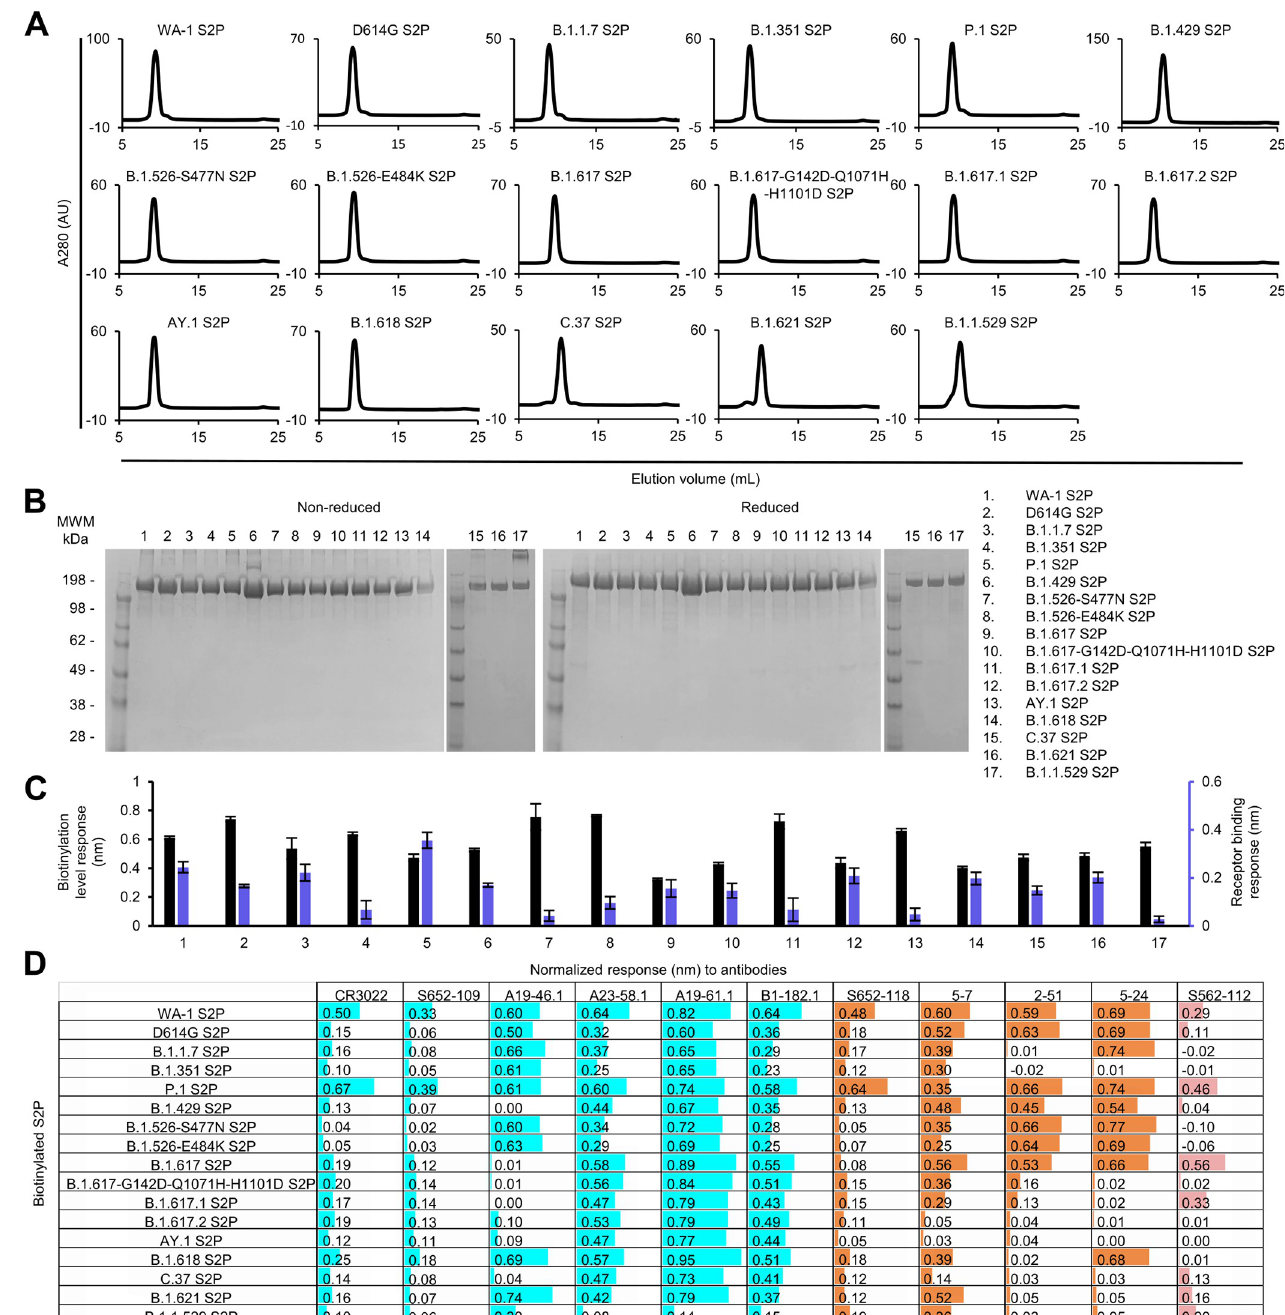
Fig 3. Characterization of purified biotinylated SARS-CoV-2 variant S2P probes confirms their homogeneity and antibody-binding specificity. (A) Size exclusion chromatography of the purified biotinylated SARS-CoV-2 S2P probes, including original WA-1 S2P, single mutated D614G S2P, and 15 other variant S2P, in PBS buffer. (B) SDS-PAGE of SARS-CoV-2 S2P variant probes with and without reducing agent. Molecular weight marker (MWM), the WA-1 S2P probe, and the D614G S2P probe, were run alongside the variant S2P probes. (C) Biotinylation and receptor recognition of the SARS-CoV-2 variant S2P probes. The level of biotinylation was evaluated by capture of the S2P probes at 10 μ g/ml onto the streptavidin biosensors using Octet. Receptor binding was assessed with 500 nM of dimeric ACE2. Error bars represent standard deviation of triplicate measurements. (D) Antigenicity assessment of the SARS-CoV-2 variant S2P probes. Responses to RBD-directed, NTD-directed, and S2 subunit-directed antibodies were shown in cyan, orange, and rose, respectively. Bar scale between 0 and 1. Negative values not depicted.